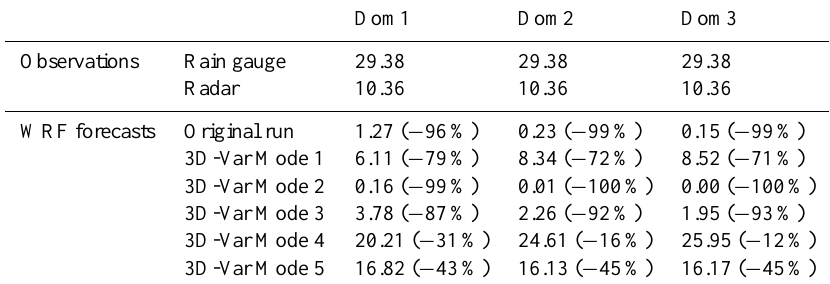
Table 4. Cumulative amounts (in mm) of rainfall observations and forecasts for the 24h storm